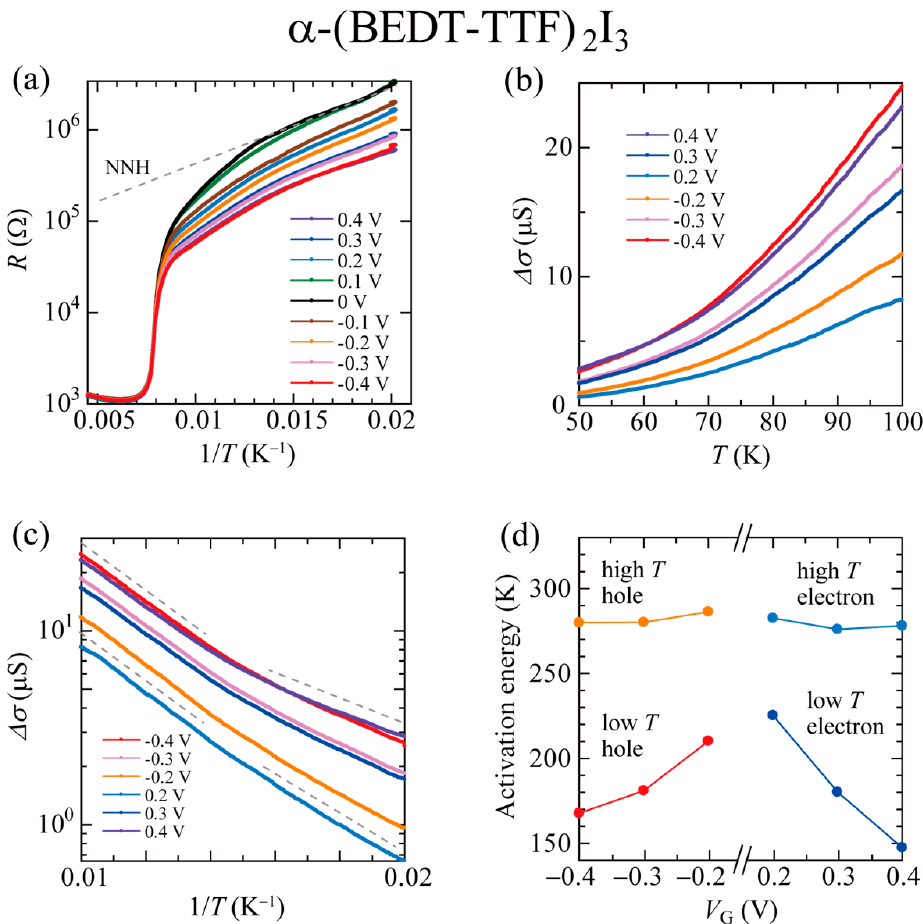
Figure 4. ( a ) Arrhenius plots of the four-probe resistance at various gate voltages in α -(BEDT-TTF) 2 I 3 . The dashed line is a guideline of the slope at low temperatures and is assigned to the NNH hopping conduction in the literature. ( b ) Temperature dependence of the gate-induced sheet conductivity. Note that the data at | V G | = 0.1 V are not shown because ∆ σ = L when R is similar to R 0V . ( c ) Arrhenius plots of the gate-induced conductivity. Dashed lines are guides to the eye. ( d ) Gate voltage dependence of the activation energy estimated at relatively high (80–100 K) and low (50–60 K)